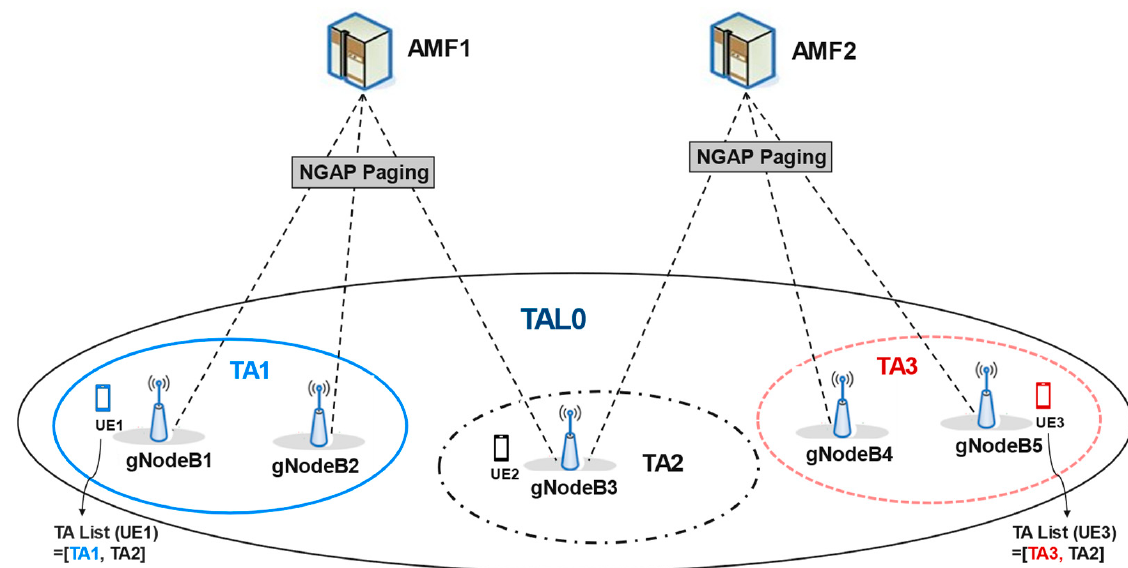
Figure 1. Next generation application protocol (NGAP) paging of 5G system.